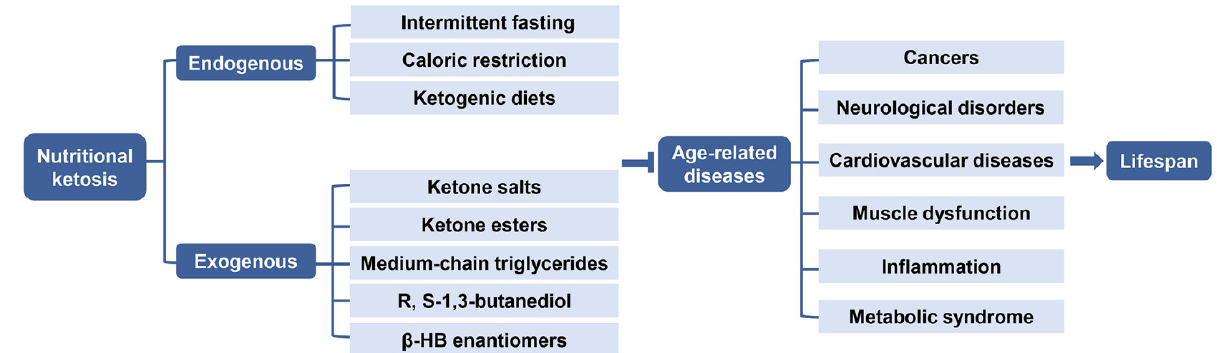
Figure 5. Role of endogenous and exogenous nutritional ketosis in age-related diseases. Nutritional ketosis can be achieved endogenously through intermittent fasting, caloric restriction, ketogenic diets or exogenously with oral supplementation via ketone salts, ketone esters, medium-chain triglycerides, R, S-1,3- butanediol, and β -HB enantiomers, resulting in a therapeutic effect in several medical conditions, thereby targeting the underlying mechanisms of age-related diseases, such as cancers, neurological disorders, cardiovascular diseases, muscle dysfunction, inflammation, and metabolic syndrome, which may extend the healthy life expectancy. Abbreviations: β -HB, β -hydroxybutyrate.